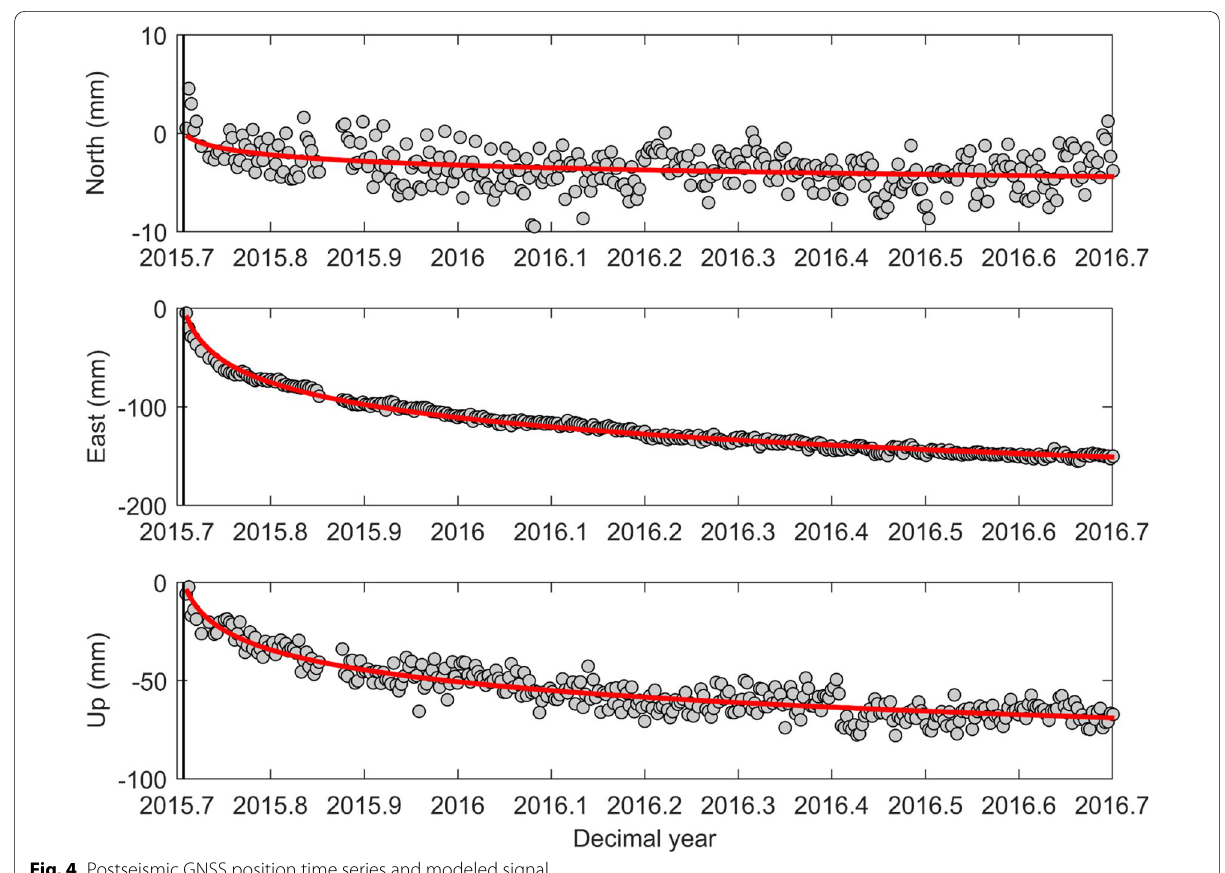
Fig. 4 Postseismic GNSS position time series and modeled